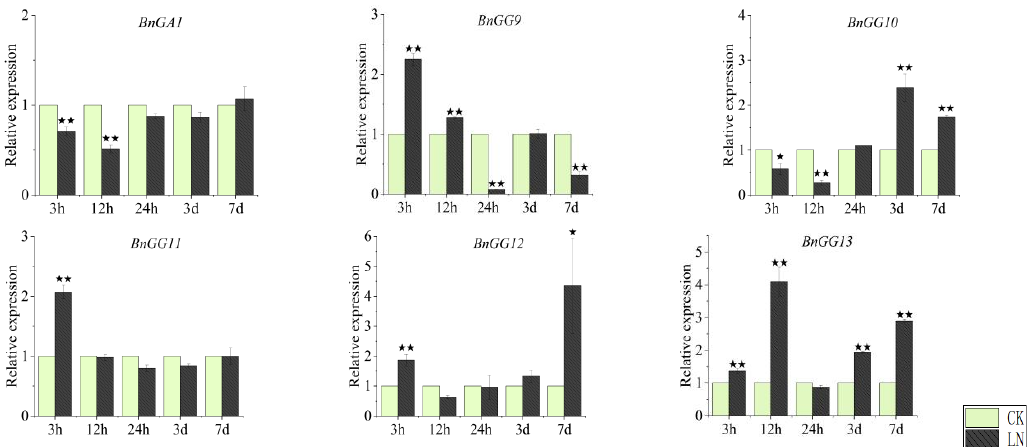
Figure 8. Expression profiles of G-protein genes in leaves under normal and nitrogen-deficient con- ditions. Quantitative RT-PCR was used to investigate the expression levels of one G α gene ( BnGA1 ) and five C-type G γ genes ( BnGG9 , BnGG10 , BnGG11 , BnGG12 , BnGG13 ). Leaves were collected un- der normal-growth and nitrogen-deficient conditions at 0 h, 3 h, 12 h, 24 h, 3 d, and 7 d after treat- ments. Data were normalized to the BnActin7 gene and vertical bars indicate standard deviation. Compared with the expression of G-protein genes in CK condition at each time point, ★ represents the significant level, ★★ represents the extremely significant level.